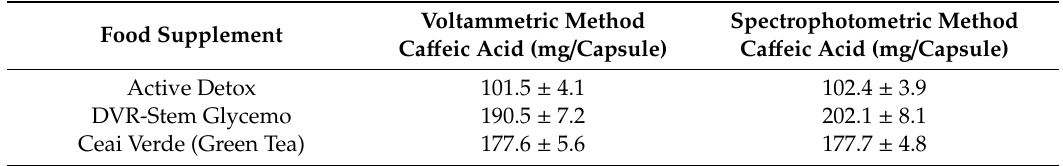
Three replicate experiments were